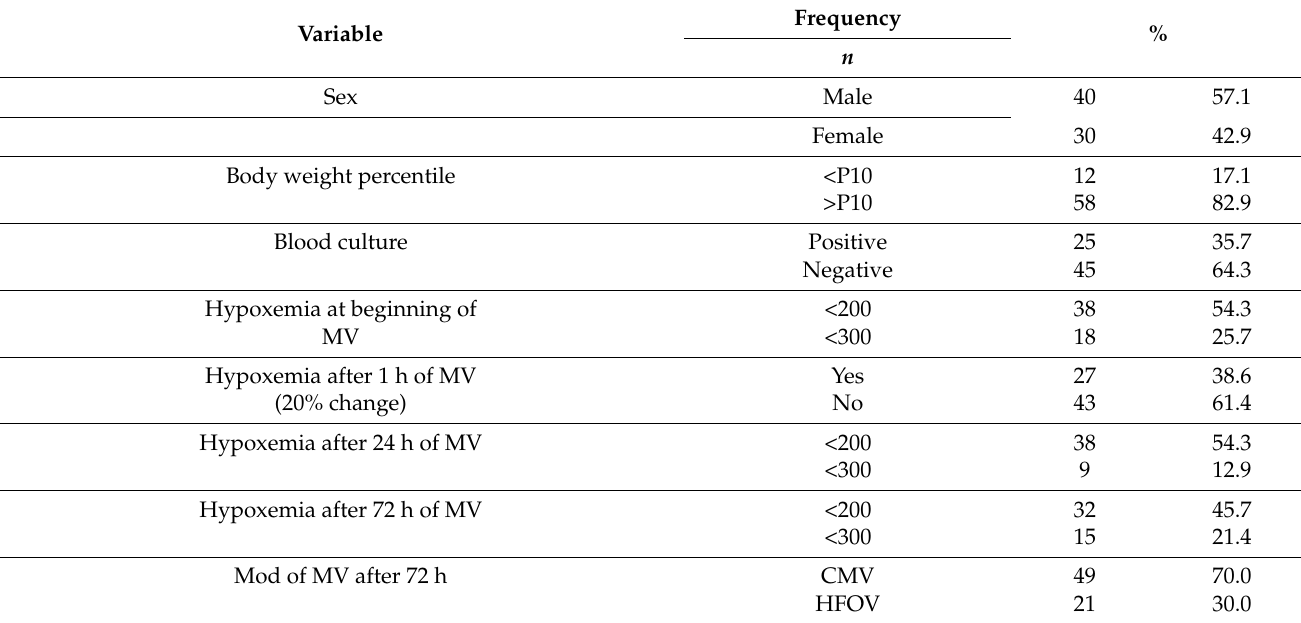
Table 1. Patients Characteristics and Clinical Parameters on Admission and Onset of MV ( n =